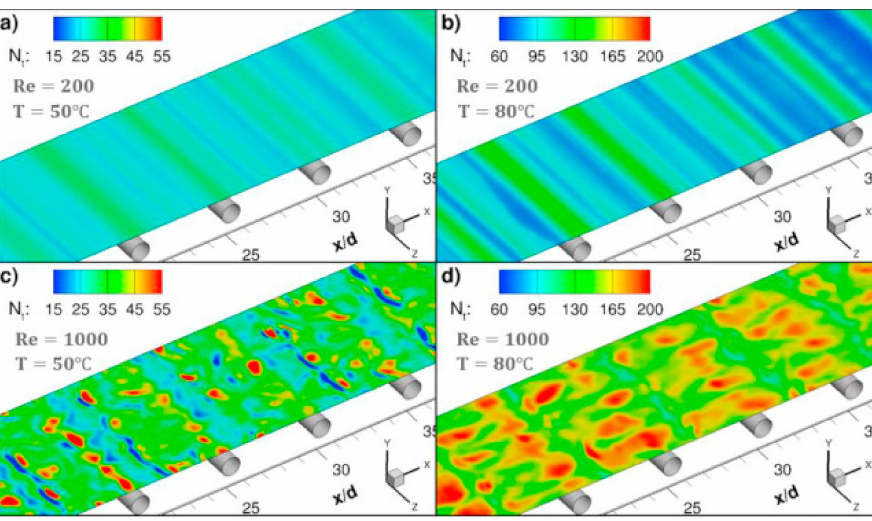
Figure 6. Instantaneous contours of the local mass flux, N t (kg/m 2 h), through the top membrane surface at a non-dimensional time τ i with the addition of filaments [17]. Reproduced with permission from Elsevier, 2019. ( a ) Reynolds Number (Re) = 200, T = 50 ◦ C; ( b ) Re = 200, T = 80 ◦ C; ( c ) Re=1000, T = 50 ◦ C; ( d ) Re = 1000, T = 80 ◦